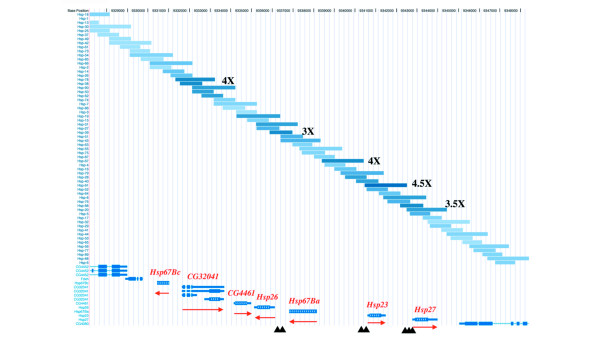
Graphical representation derived with the University of California at Santa Cruz (UCSC) genome browser of fragment enrichments in the 67B region containing eight putative Hsp genes (CG32041 encodes a dicistronic transcript). The blue fragments represent the 1-kb and 2-kb tiling fragments with the intensity of the blue color reflecting the degree of enrichment (asinh ratio); selected regions have been labeled with fold enrichments. The direction of transcription for each of the Hsp genes is indicated by the red arrow. The black triangles at the bottom indicate the locations of known HSEs.